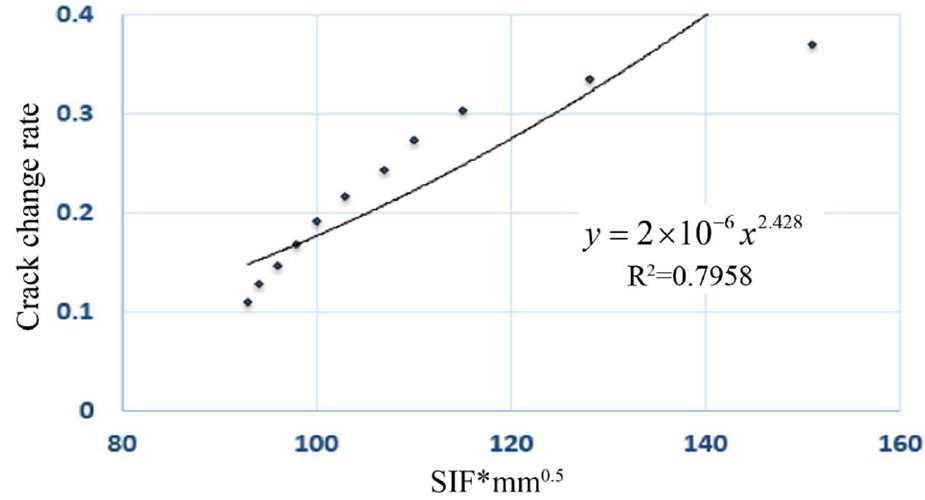
Figure 11. The relationship between crack change rate and SIF.